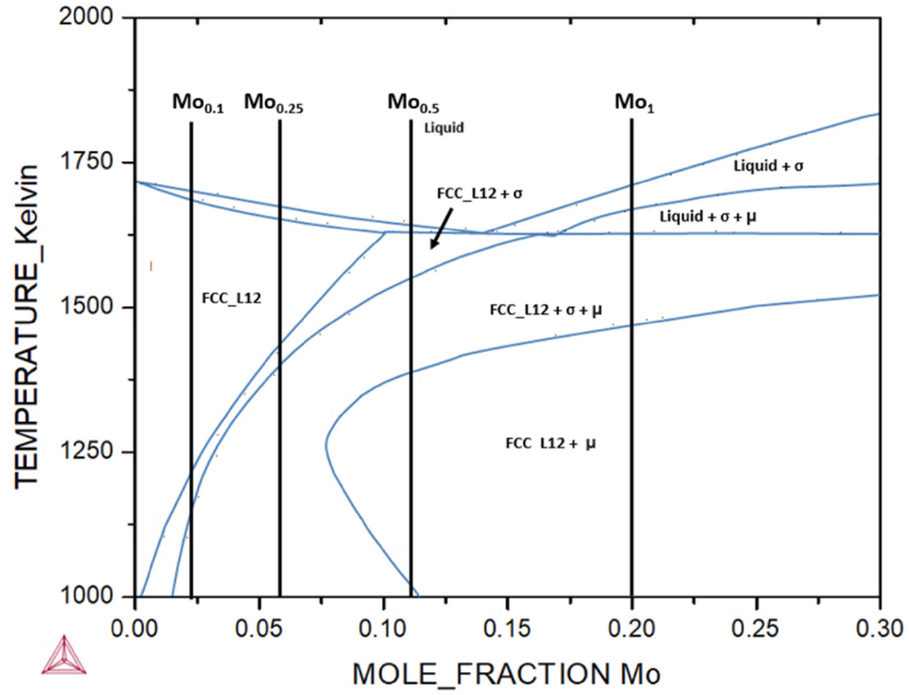
Figure 1. Pseudo-binary phase diagram of CoCrFeNi-Mo system.